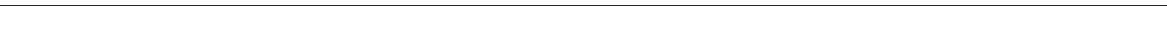
Fig. 4 Bilirubin as potential source of NIRAF. a NIRAF image of tetrapyrrole-containing compounds involved in heme metabolism using the Odyssey Infrared Imaging System. NIRAF signals in both channels (Ex 685 nm, Em > 700 nm; Ex 785 nm, Em > 800 nm) were detected from protoporphyrin IX and bilirubin, while hemoglobin, ferrous stabilized hemoglobin and biliverdin did not show any signi fi cant NIRAF. b Bar graph of mean absorbance ± SEM suggestive of the differences in bilirubin content in the high and low NIRAF human CEA plaque segments (seven in each group). Plaque segments with high NIRAF had signi fi cantly higher bilirubin content ( p < 0.01, unpaired Student ’ s t -test). c Mass spectrometry measurements of bilirubin, biliverdin and heme concentrations in unstable (TS segment I) vs. stable plaques (TS segment V) at 1, 4, and 7 weeks post TS surgery. The bilirubin concentration is signi fi cantly elevated in the unstable plaque 7 weeks post TS surgery (** p < 0.05, *** p < 0.01, Kruskal – Wallis test followed by Dunn ’ s multiple comparisons test. The heme and biliverdin concentrations also shows a similar trend, although statistically not signi fi cant ( p = 0.061, p = 0.18, Kruskal – Wallis test followed by Dunn ’ s multiple comparisons test). Bilirubin, biliverdin and heme concentrations remained unchanged in the stable plaques. d Fluorescence microscopy suggestive of the co-localization of bilirubin and NIRAF (Ex: 740/13 nm, Em: 809/81 nm) in human unstable plaques. From left to right: bright fi eld microscopy image, fl uorescence image of anti-bilirubin antibody labeled with Alexa 647 ( red color ), NIRAF image ( green color ), merged image (overlaying bilirubin fl uorescence image and NIRAF image) are shown. Bilirubin and NIRAF co-localization can be seen in the merged image ( yellow color ). Experiments were performed three times and one representative example is shown. Scale bar indicates 50 µ